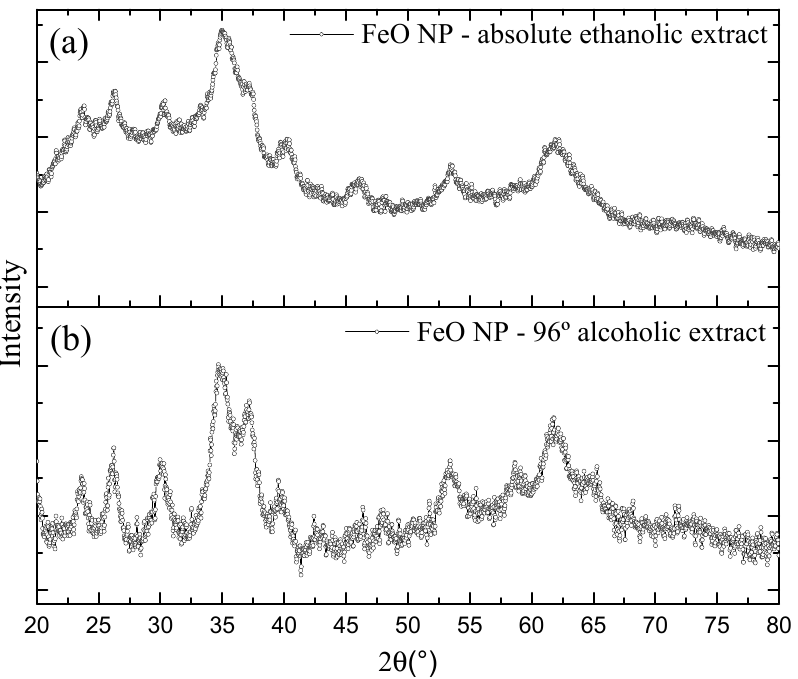
Figure 5. Characterization by XRD of FeO NP synthesized with extracts in solvents ( a ) ethanolic absolute, ( b ) alcoholic 96%. absolute, ( b ) alcoholic